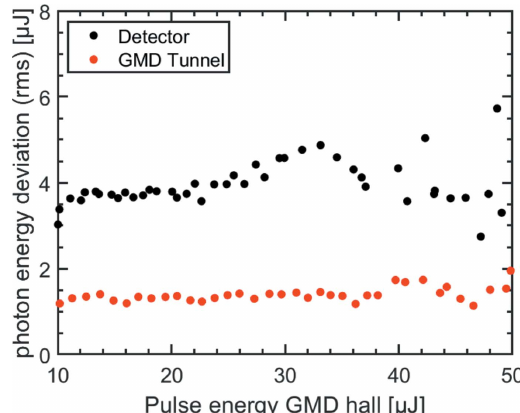
Figure 7 Calibration measurement of the relative pulse intensity measurement device (PATIM detector) at a wavelength of (cid:4) = 8.5 nm on a shot-to-shot basis with respect to the GMD in the hall. Over the considered pulse energy range, the absolute energy deviation is (cid:6) E pulse ’ 4 m J (r.m.s.). The pulse energy measured by the tunnel GMD is simultaneously obtained and given as a reference with (cid:6) E pulse < 2 m